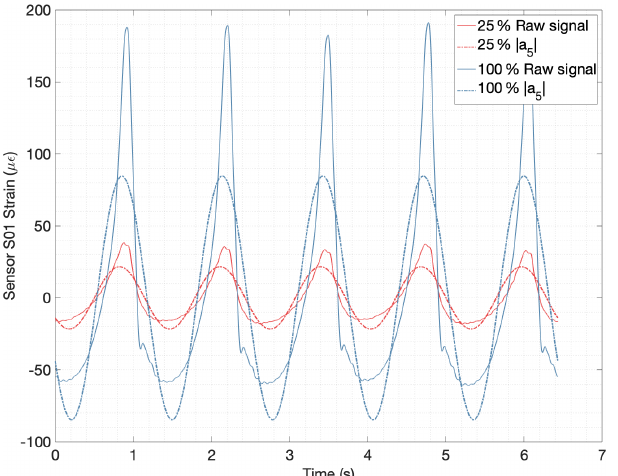
Figure 15. Original strain signal of sensor S01 for one shaft revo- lution vs. reconstructed signal using the fifth harmonic component a 5 (two load cases are compared with 25% torque in red and 100% torque in